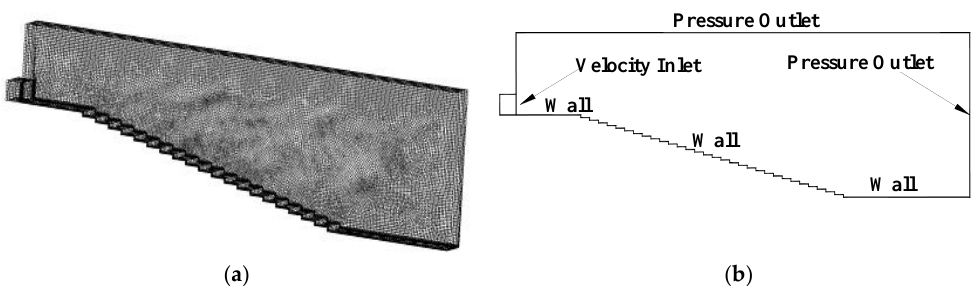
Figure 3. Numerical stepped spillway model and boundary conditions: ( a ) three-dimensional numerical stepped spillway model, ( b ) boundary conditions applied to the